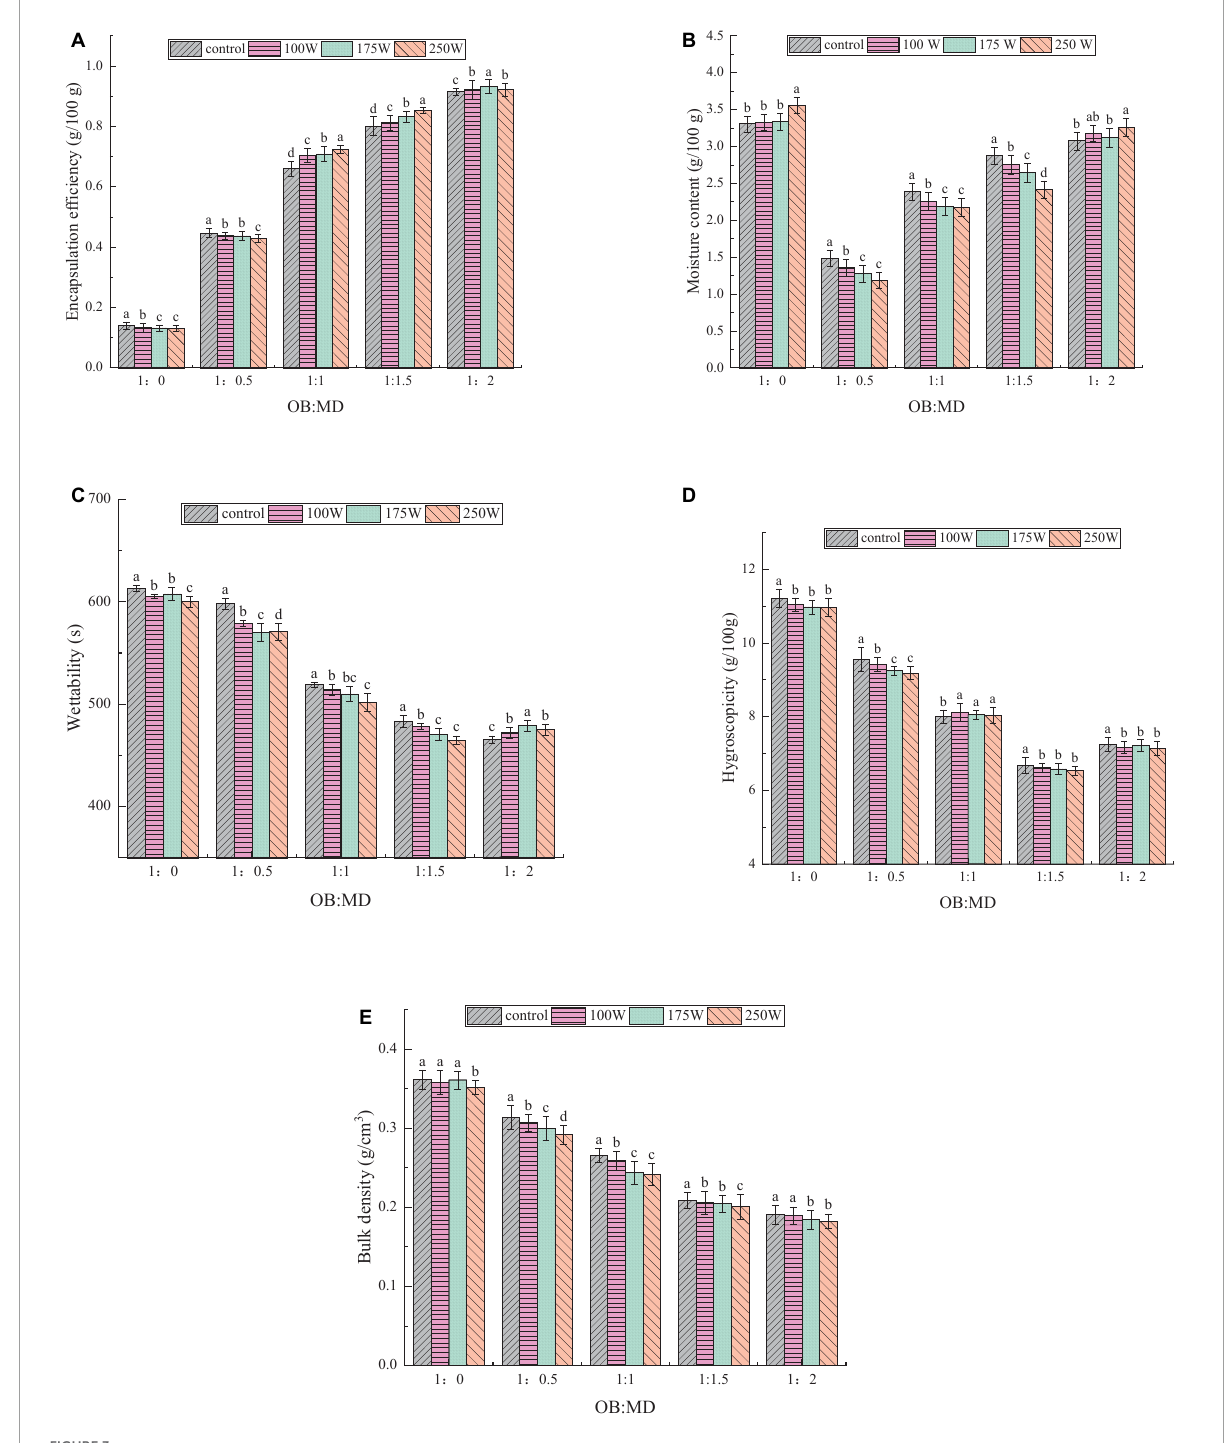
FIGURE3 Effect of different dextrin additions and ultrasonic power on the physicochemical property of freeze-dried OB-MD microcapsules: (A) Encapsulation efficiency (%), (B) moisture content (g/100g), (C) wetting time (s), (D) hygroscopicity (g/100g), and (E) bulk density (g/cm 3 ). Different letters (a–d) in the figure indicate significant differences ( P <